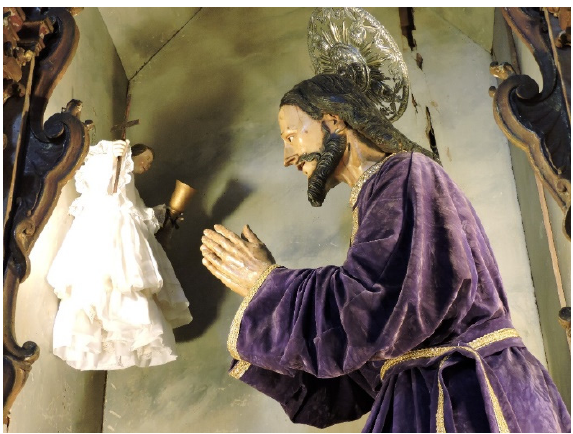
Figure 10. Detail of the Angel of Bitterness. Photo by Lia Brusadin, 26 December 2016.